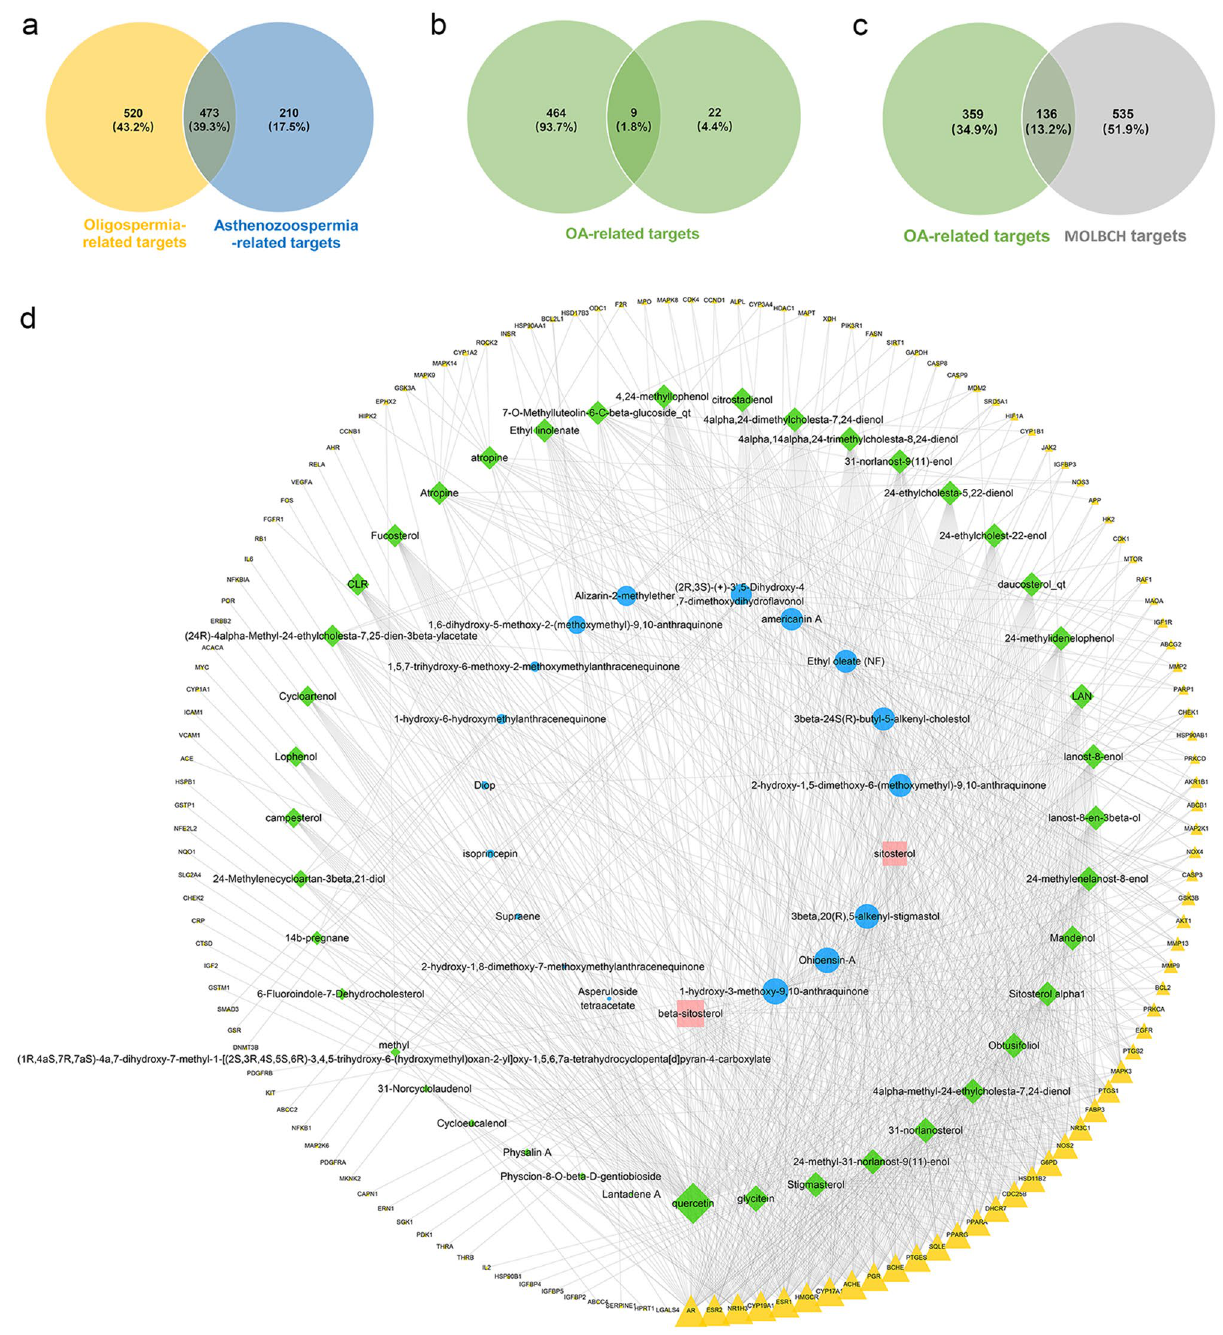
Figure 2. MOLBCH-OA common-target network. ( a ) Intersection of Venn diagram: 473 targets are common to oligospermia and asthenozoospermia. ( b ) Union of Venn diagram: OA-related targets are 495, including 473 common targets between oligospermia and asthenozoospermia, and 31 targets from the search term “oligoasthenozoospermia”. ( c ) Intersection of Venn diagram: 136 targets are common to OA and MOLBCH. ( d ) Common-target network, including 196 nodes and 900 edges. The size of the circle represents the node degree of the target protein. Green nodes and blue nodes stand for bioactive components from MO and LB respectively, yellow nodes stand for targets, pink nodes stand for beta-sitosterol and sitosterol. OA, oligoasthenozoospermia; MOLBCH, Morinda officinalis - Lycium barbarum